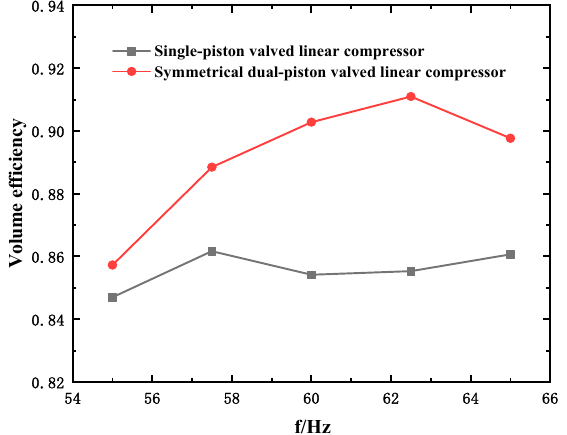
Figure 18. The volumetric efficiencies of the two types of linear compressors at different frequencies, obtained from the experiments.